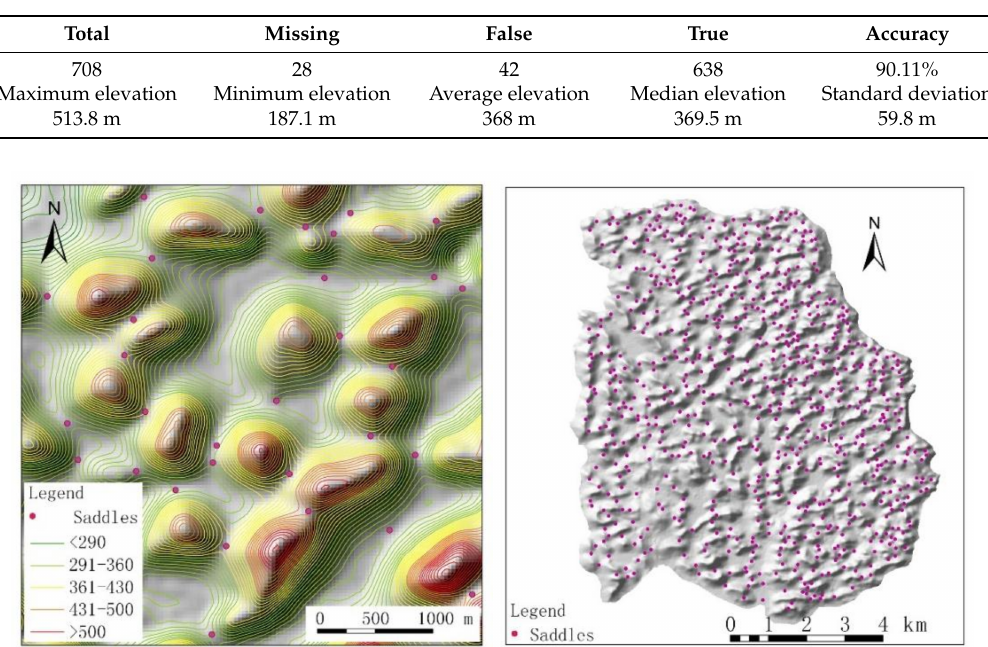
Table 1. Statistics on number and elevation of extracted saddle points.